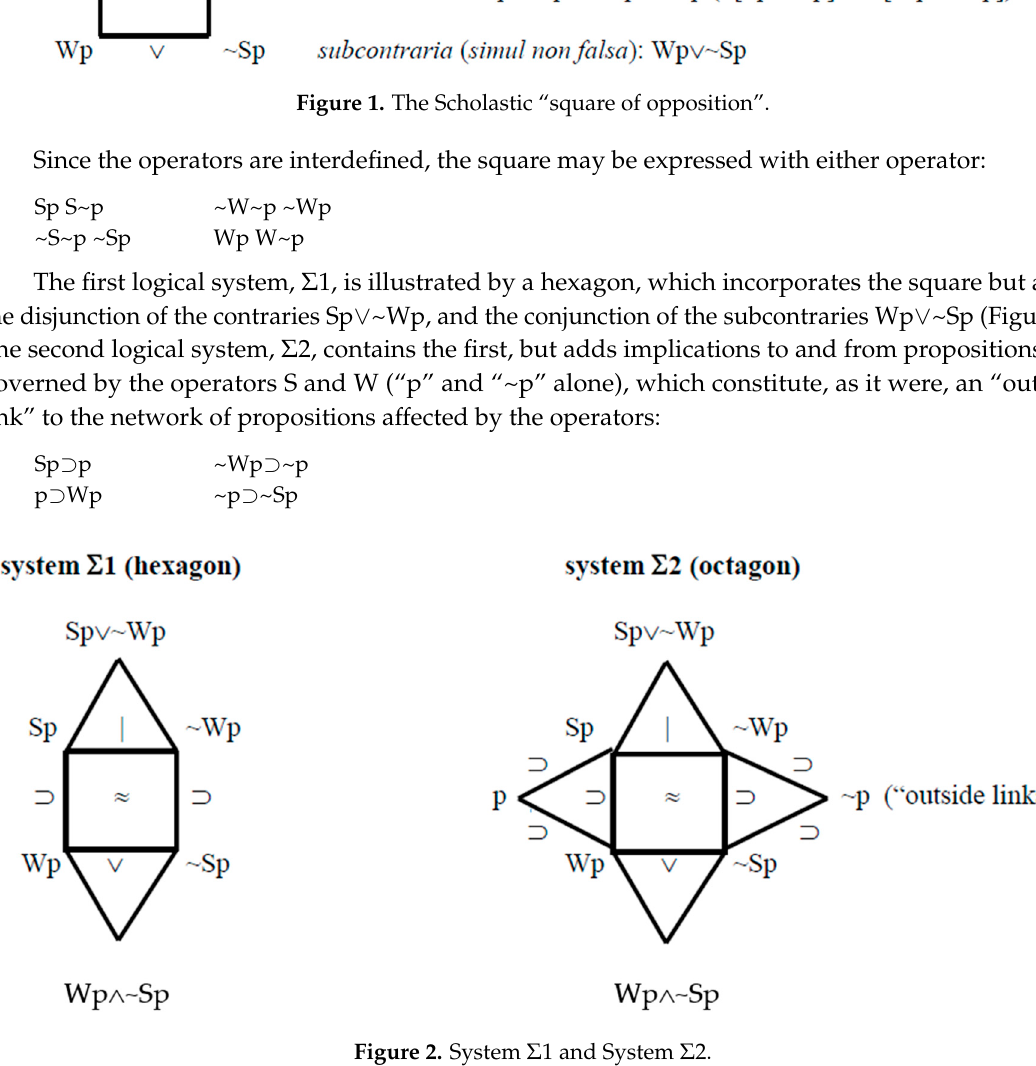
Figure 1. The Scholastic “square of opposition”.